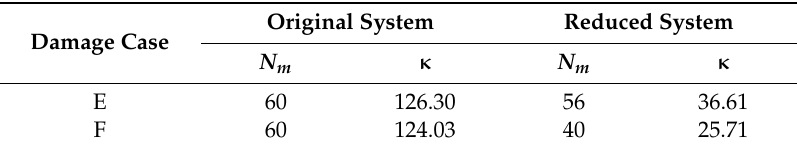
Table 3. The number of equations ( N m ) and the corresponding condition number ( κ ) of the original and reduced CMSE systems for damage cases E and F.